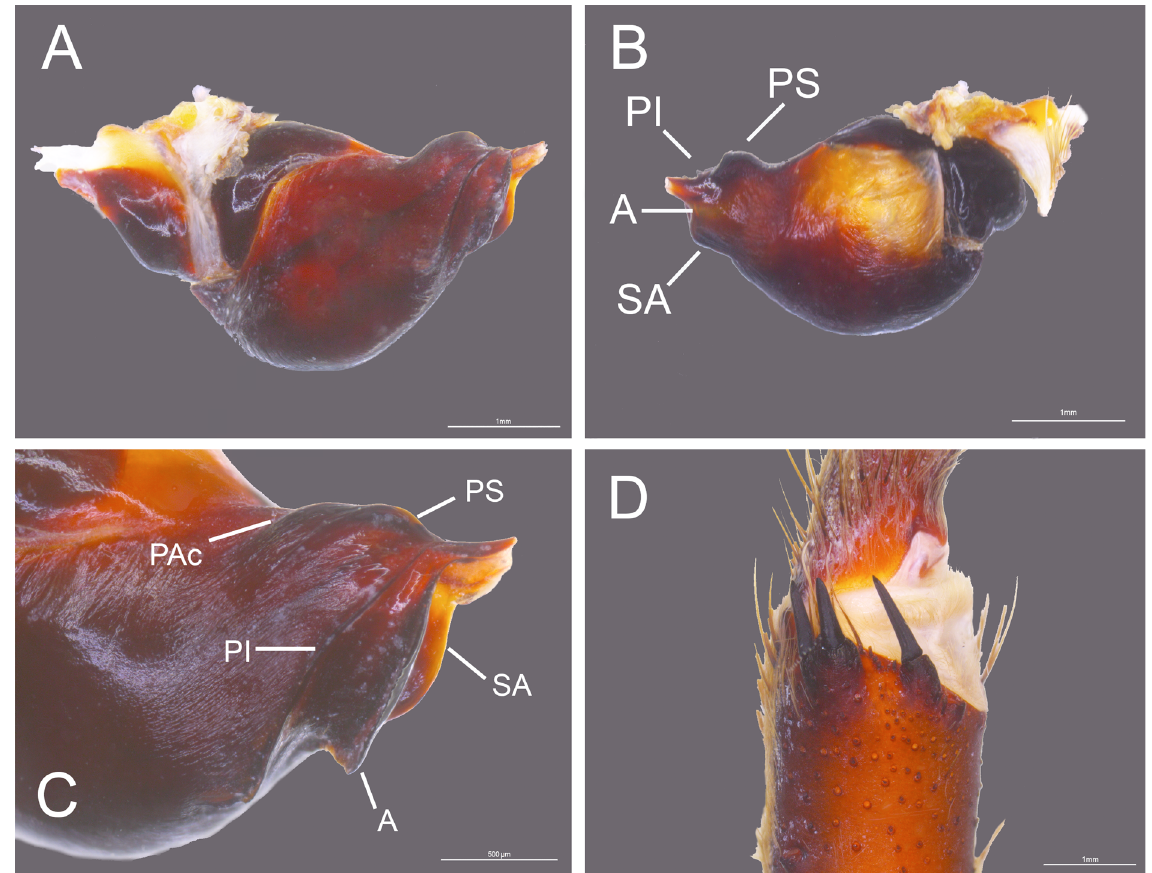
Fig. 23. Umbyquyra tapajos gen. et sp. nov., paratype, ♂, Flona do Tapajós, Belterra, Pará, Brazil (IBSP 161728). A . Palp, prolateral. B . Retrolateral. C . Anterolateral, distal area. D . Tibial apophysis, retrolateral. Abbreviations: see Material and